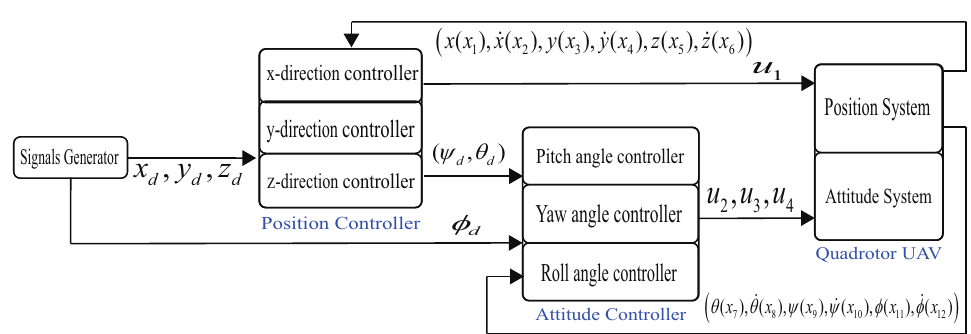
Figure 2. Control scheme of